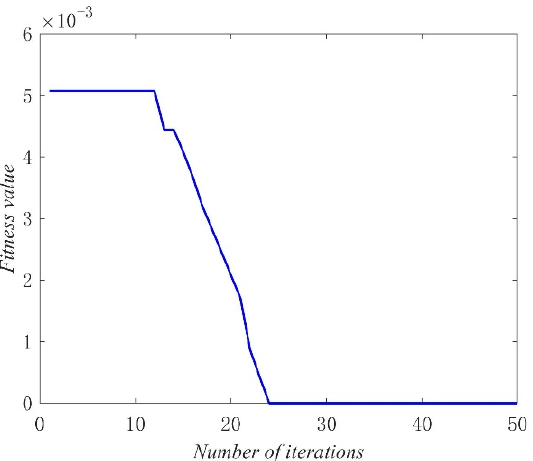
Figure 14. The example curve of the optimal individual fitness function.